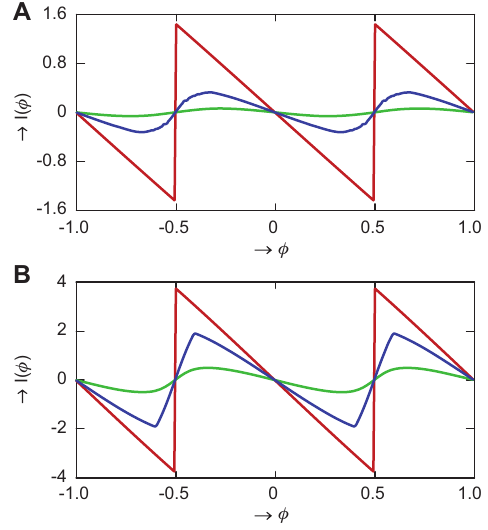
Figure 8 Persistent current as a function of fl ux φ for single-chan- nel mesoscopic rings with N = 15 considering one-third electron fi ll- ing. (A) Rings with only NNH integral. The red line corresponds to the ordered non-interacting ring, while the green and blue lines correspond to the disordered ( W = 2) rings with U = 0 and 0.5, respec- tively. (B) Rings with NNH and SNH integrals. The red line repre- sents the ordered non-interacting ring, whereas the green and blue lines correspond to the disordered ( W = 2) rings with U = 0 and 1.5,